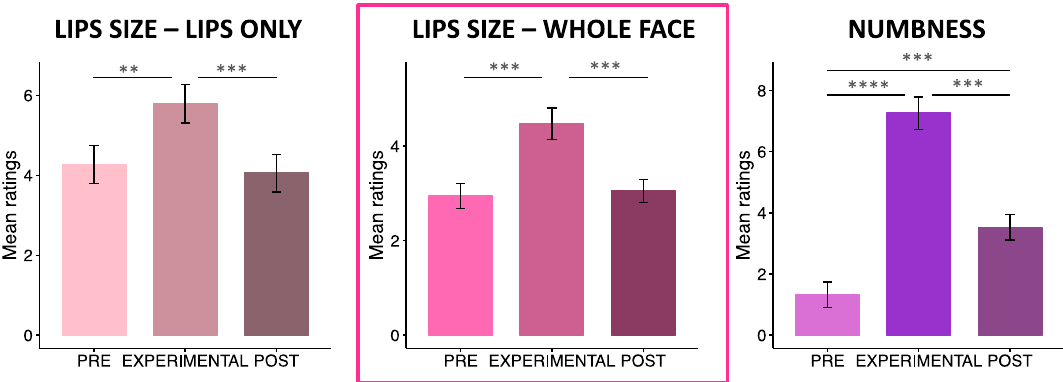
Figure 1. Mean rating scores for the lips size (lips only and whole face ratings) and numbness across time points (PRE, EXPERIMENTAL, POST) of Experiment 1. The error bars indicate the standard error of the